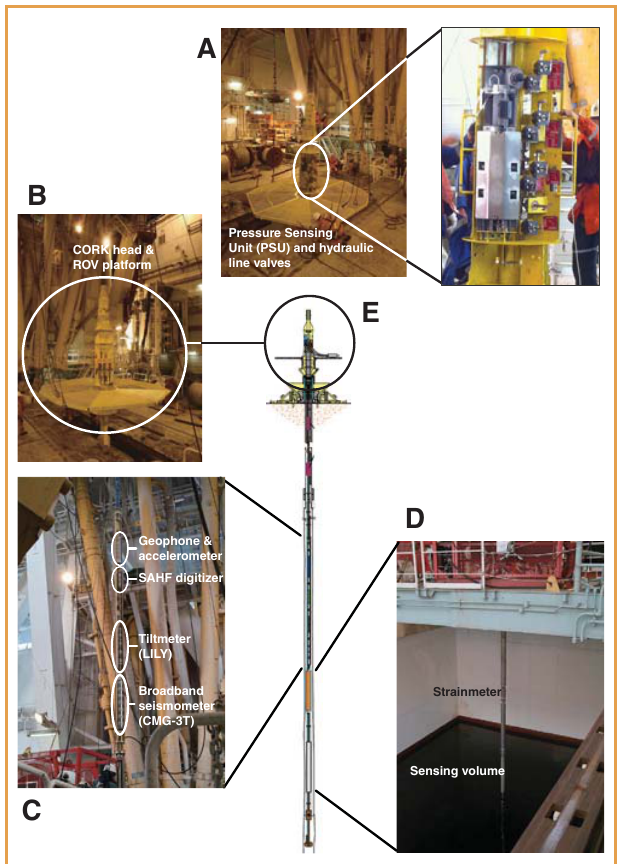
Figure 4. The sensors and placement on the LTBMS CORK observatory at Site C0002. Photos of the different sensor packages and their arrangement on the downhole and CORK head sections were taken during deployment. [A] The Pressure Sensing Unit (PSU), an independent sensor array mounted on the CORK head. [B] CORK head and ROV platform. [C] Sensor carrier, with a geophone and accelerometer assembly, a stand-alone heat flow meter (SAHF) digitizer for the thermistor string, a LILY tiltmeter, and a CMG-3T Guralp seismometer. [D] Strainmeter and sensing volume. [E] Diagram of the Site C0002 CORK